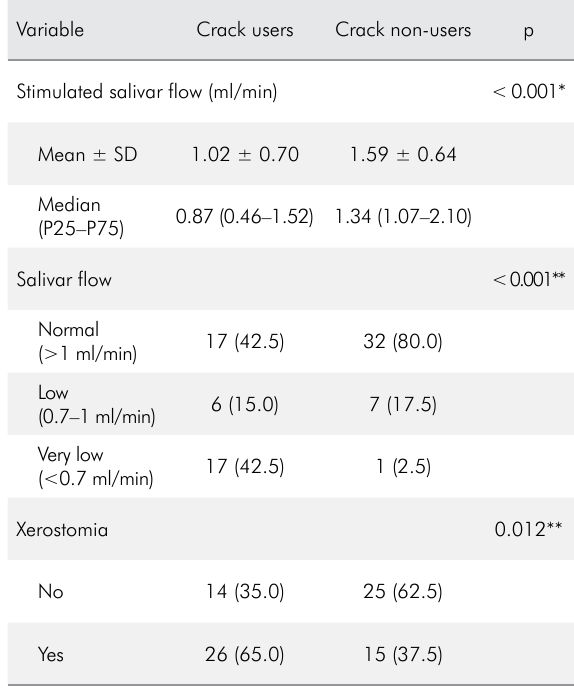
Table 2. Comparison of stimulated salivary flow and xerostomia between crack users and non-users (n = 40).